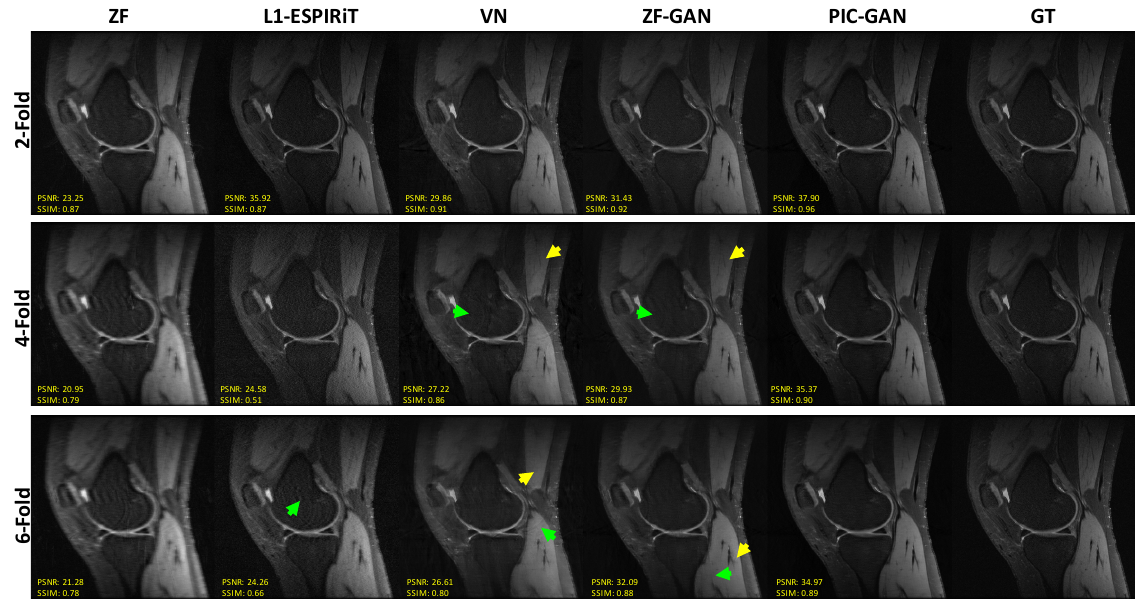
Figure 5. Comparison of different reconstruction methods with different acceleration factors for the knee dataset. From left to right, each column represents selected knee image reconstructed using ZF, L1-ESPIRiT, VN, ZF-GA and PIC-GAN, respectively, compared to the GT. (GT: Ground truth. ZF: Zero-filled. L1-ESPIRiT: Sparsity-based parallel imaging. VN: Variational network. ZF-GAN: Conventional GAN with single-channel images as input PIC-GAN: Our proposed method. The ZF-GAN reconstructed images were over-smoothed with blocky artifacts (yellow arrows) and obvious residual artifacts (green